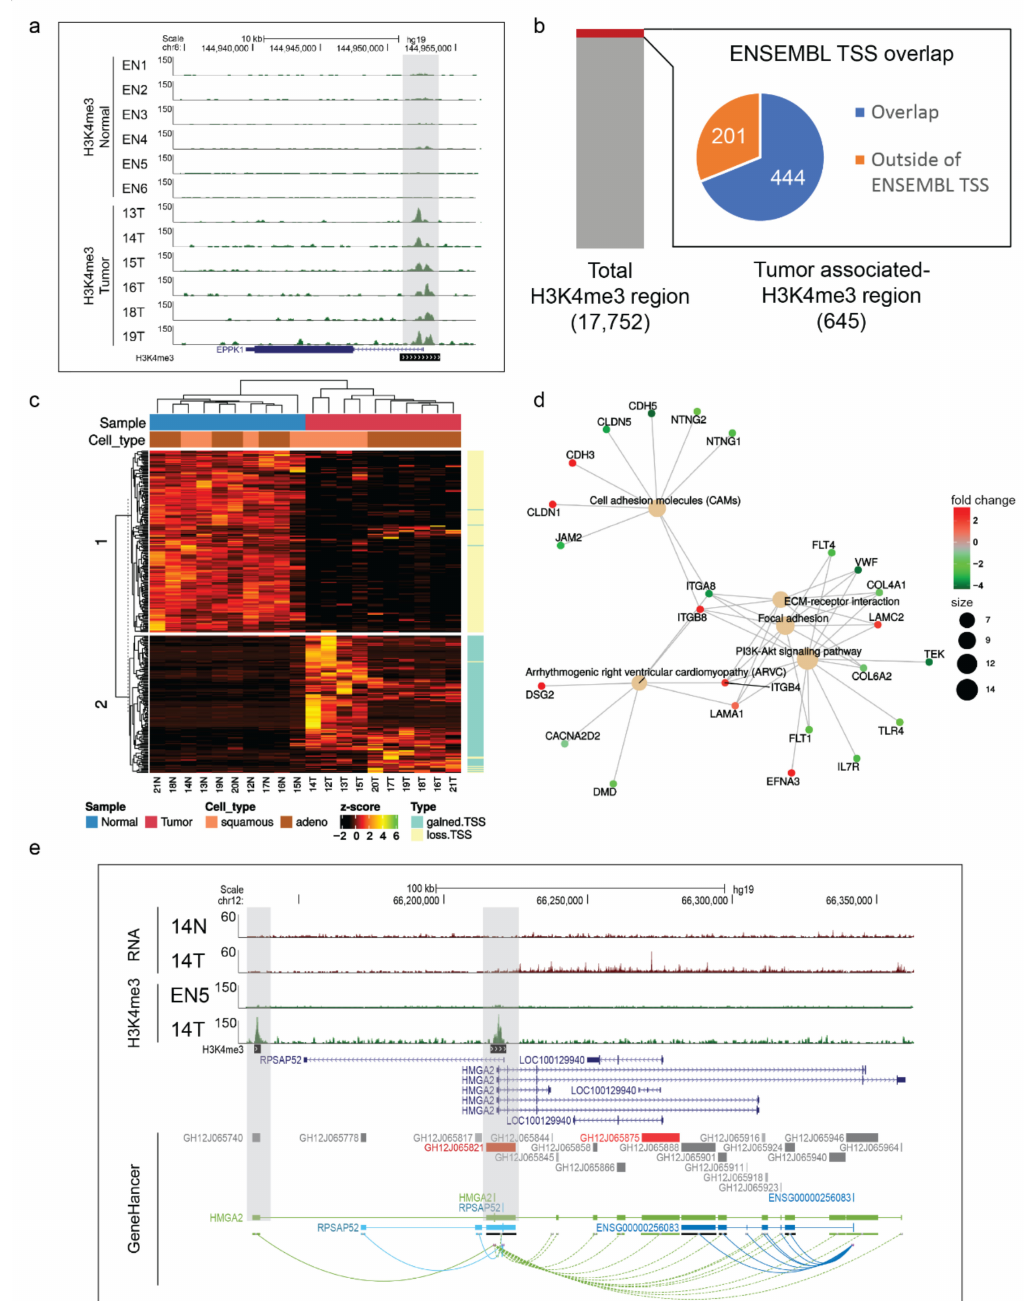
Figure 3. ( a ) Example of a tumor-gained function promoter. The UCSC genome tracks of the EPPK1 TSS (grey shaded box) highlight the gain of H3K4me3 signals in NSCLC samples (13T, 14T, 15T, 16T, 18T, 19T) compared with ENCODE normal lung samples (EN1, EN2, EN3, EN4, EN5, EN6). ( b ) Determining overlaps between 645 tumor-altered H3K4me3 regions with ENSEMBL TSS (+/ − 1 kb) regions. A total of 444 (69%) tumor-altered H3K4me3 regions overlapped while 201 (31%) were outside ENSEMBL TSS. ( c ) Heatmap of RNA-Seq read densities (row scaled) of 310 tumor vs. normal DEGs, whose TSSs intersected with tumor-altered H3K4me3 regions. ( d ) Cnet-plot from the KEGG pathway enrichment analysis of these 310 DEGs. KEGG pathways are shown with beige dots. ( e ) A capture of the UCSC genome illustrating the tumor-gained H3K4me3 signals (grey shaded boxes) at HMGA2’s TSS and potential enhancer regions defined by the GeneHancer database (GeneHancer IDs: GH12J065821 for the promoter, GH12J065740 for the enhancer). The two RNA tracks are RNA-Seq signals of tumor and normal samples of case 14. The two H3K4me3 tracks are ChIP-Seq signals of the case 14 tumor sample and ENCODE normal sample